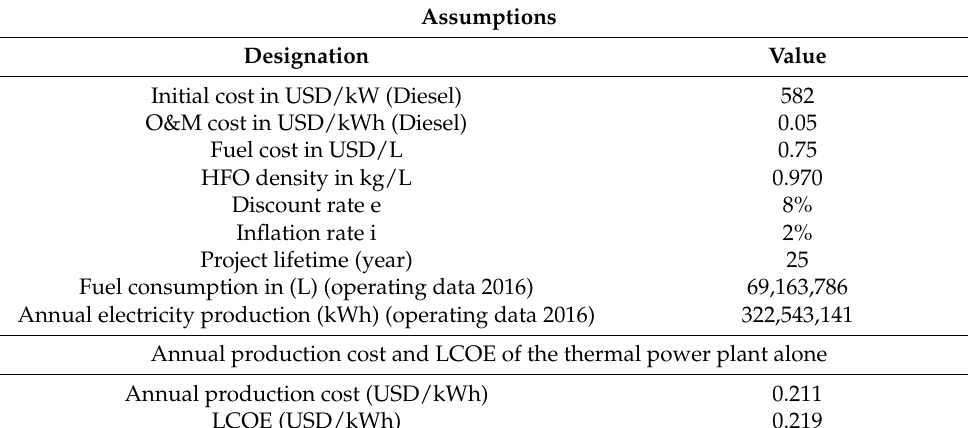
Table 10. Assumptions for the thermal power plant alone [2,6,23,33] LCOE calculation result.